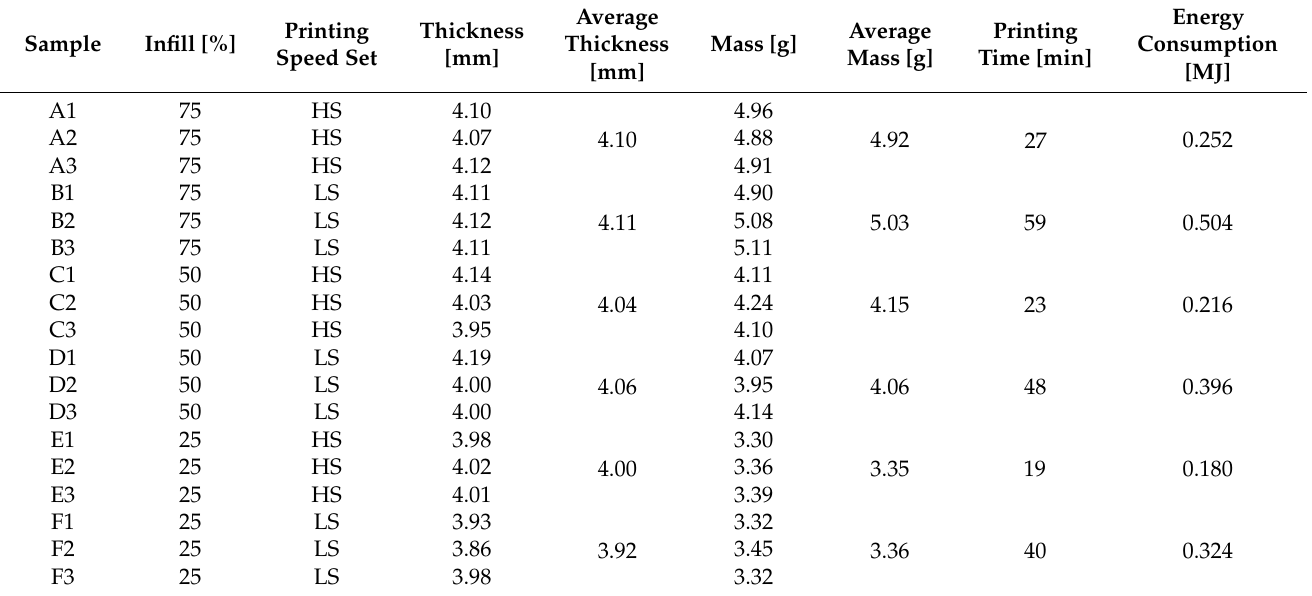
Table 6. Characterization of thickness, weight, printing time and energy consumption for the fabrication of tensile specimens using the modified printer with the Mahor extruder.